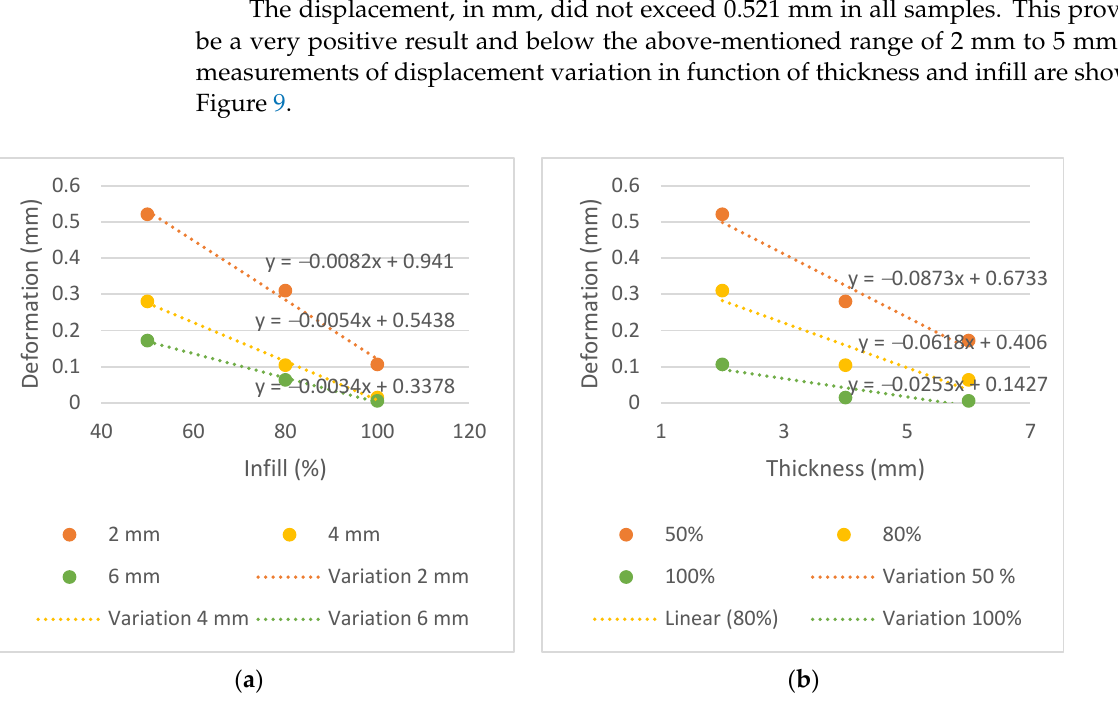
Figure 9. Variation in plate displacement, in mm, ( a ) by infill and ( b ) by thickness for pressure of 6726 Pa.